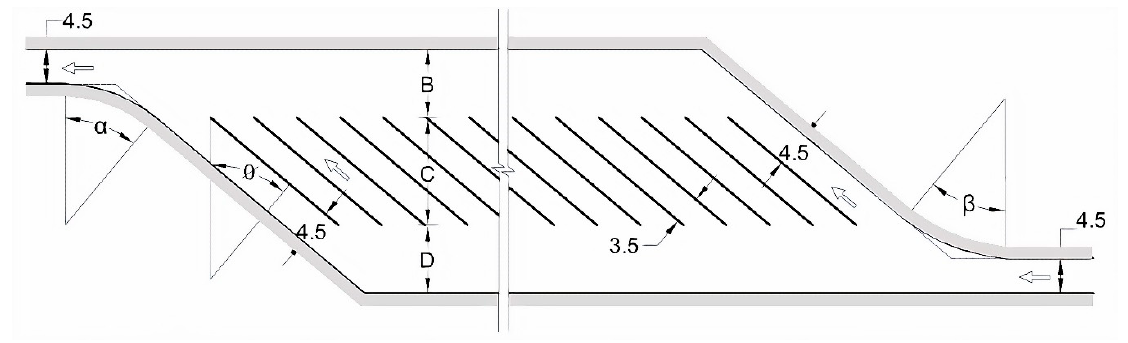
Figure 15. Elements of breakdown of the parking space for trucks: α – β —parking angle; Ø—vehicle installation angle; B–D—manoeuvring strip; C—parking module length. Table 4. The length of parking spaces for longitudinal design vehicles.